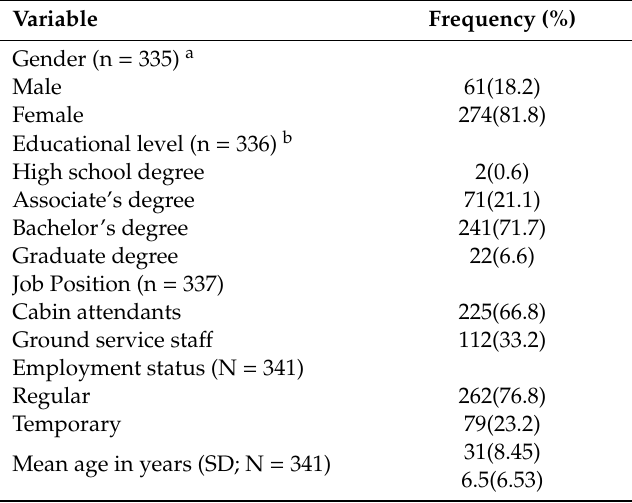
Table 1. Demographical profile of the study